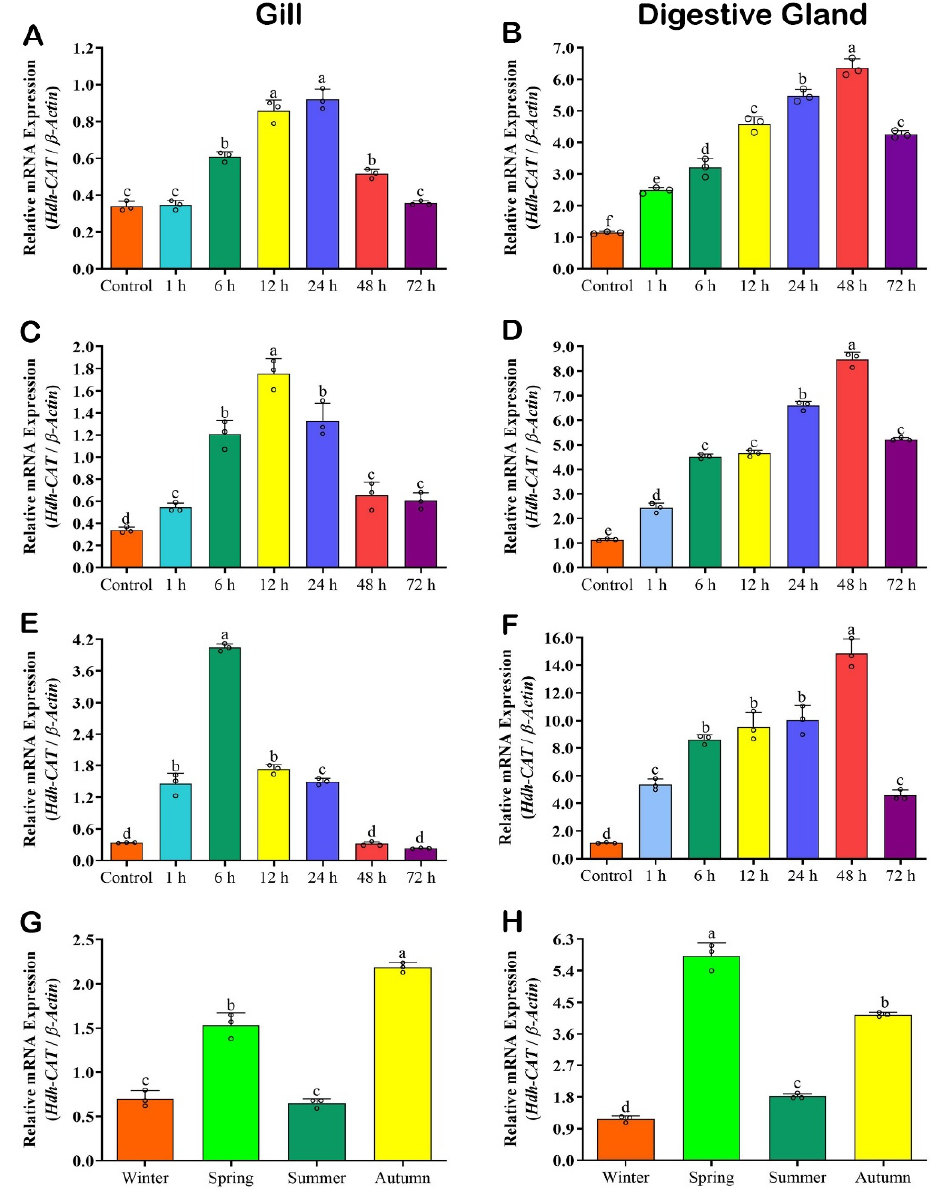
Figure 3. Hdh-CAT mRNA expression levels in thermal stressed and during elevated seasonal temperatures of Pacific abalone at different time points. ( A ) Cold-stressed (15 ◦ C) gill samples. ( B ) Cold-stressed digestive gland (DG) samples. ( C ) Heat-stressed (25 ◦ C) gill samples. ( D ) Heat-stressed (25 ◦ C) DG samples. ( E ) Heat-stressed (30 ◦ C) gill samples. ( F ) Heat-stressed (30 ◦ C) DG samples. ( G ) Hdh-CAT mRNA expression level in gill during elevated seasonal temperatures. ( H ) Hdh-CAT mRNA expression level in DG during elevated seasonal temperatures. Different letters above the bars indicate significant differences ( p <